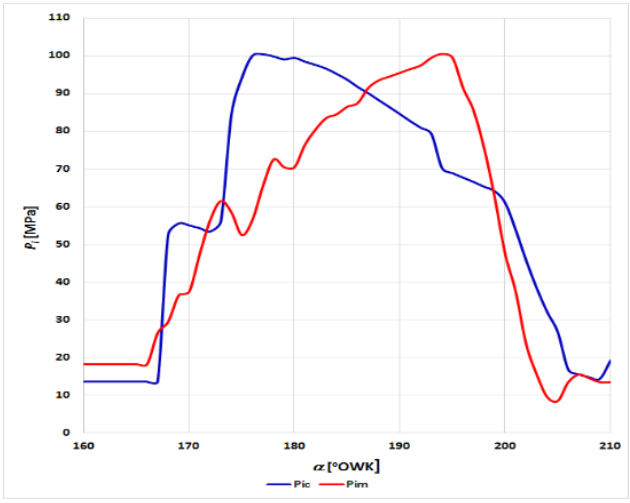
Figure 5. Comparison of the pressure course of the calculated p ic in the injector nozzle space and measured before the injector valve p im.